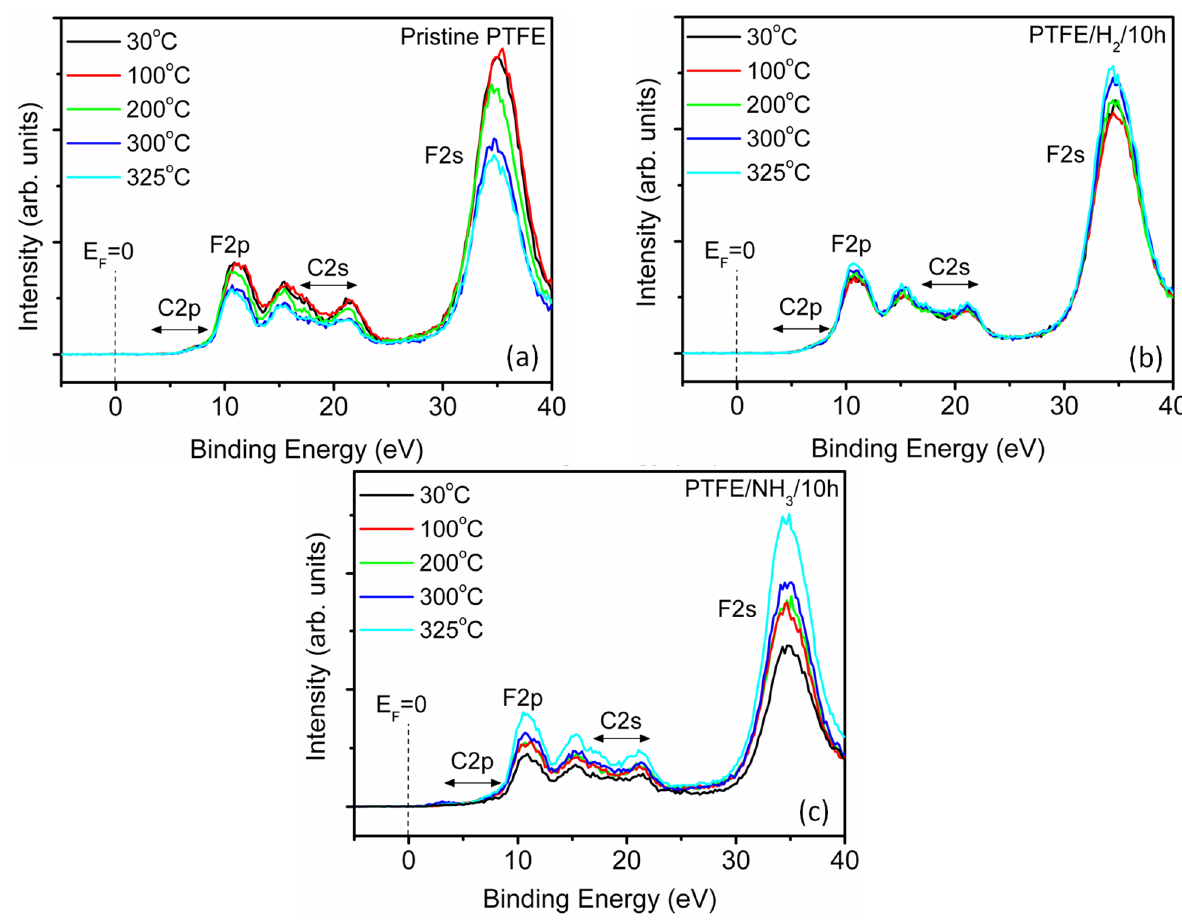
Figure 4. Evolution of valence band as a function of temperature for ( a ) Pristine PTFE. ( b ) H 2 plasma treated PTFE. ( c ) NH 3 plasma treated